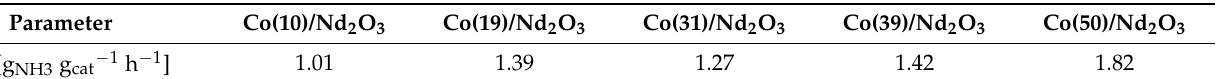
Table 4. The activity of Co/Nd 2 O 3 catalysts in ammonia synthesis reaction expressed as the average reaction rate (r avg ) and TOF.